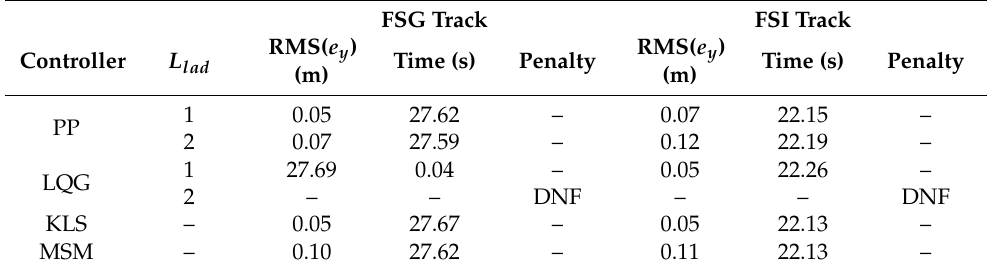
Table 4. Trackdrive results.